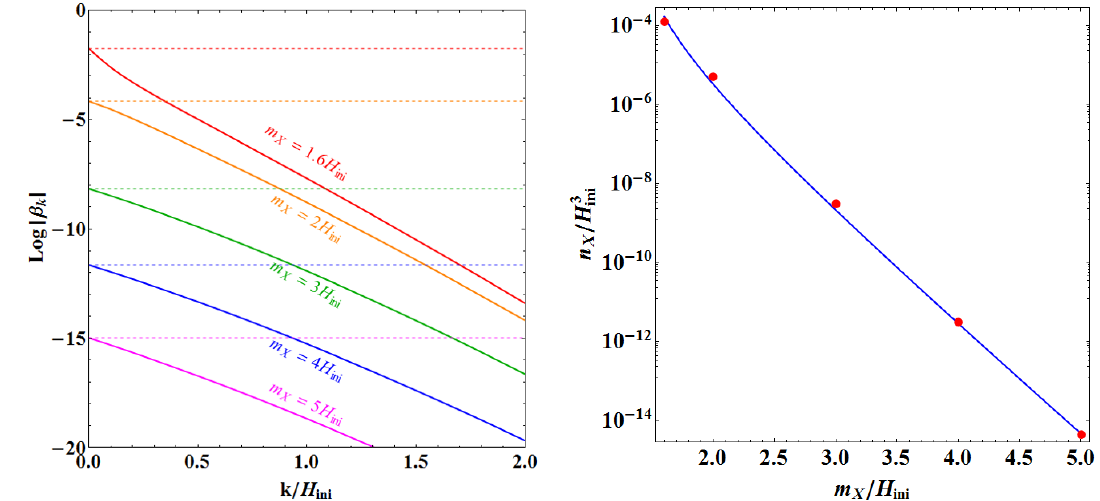
Figure 2 . Left: log j (cid:12) k j as a function of k for di(cid:11)erent m X . The exact de Sitter solutions correspond to the dashed lines (See section 2.1) while the solid curves are evaluated from eq. (2.19). Right: n X as a function of the mass of the dark matter m X . The red dots are from numerical integration of eq. (2.19). The blue line is the numerical (cid:12)tting result from eq.